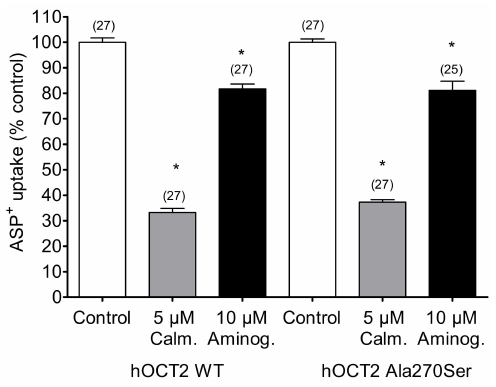
Figure 4. Regulation of hOCT2 WT- and hOCT2 Ala270Ser-mediated ASP + uptake (mean ± SEM) under inhibition of calmodulin by 10 min incubation with five calmidazolium or under inhibition of p56 lck tyrosine kinase by 10 min incubation with 10 µ M aminogenistein. These maneuvers resulted in a strong significant inhibition (*, p < 0.05, ANOVA with Tukey post-hoc test) of transport in both cell lines, compared to that observed in control experiments. However, the degree of inhibition was not di ff erent in hOCT2 WT and hOCT2 Ala270Ser cells. The number of replicates measured in at least three independent experiments is shown on the top of the